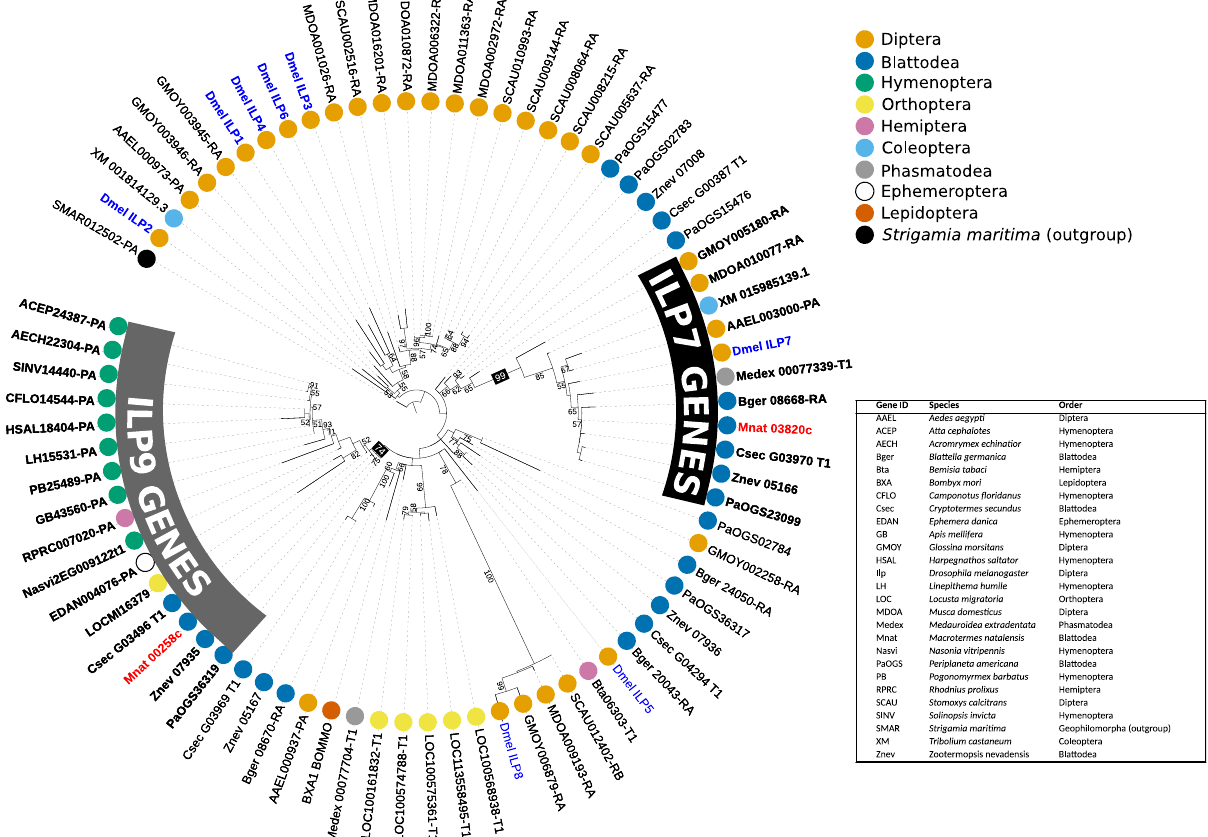
Fig. 4 Phylogenetic tree of ILP genes in several insect species. The two ILPs found in the M. natalensis genome ( Ilp7 = Mnat03820c and Ilp9 = Mnat00258c) are highlighted in red and the eight Drosophila genes ( DILPs ) are highlighted in blue. All other species can be identi fi ed by their GeneID displayed in the Table. The tree was constructed with iqtree2 (Q.pfam + R4 model and 10,000 bootstraps) and visualized with iTOL (v. 6). Branch labels are bootstraps, the tree is rooted at the Strigamia maritima